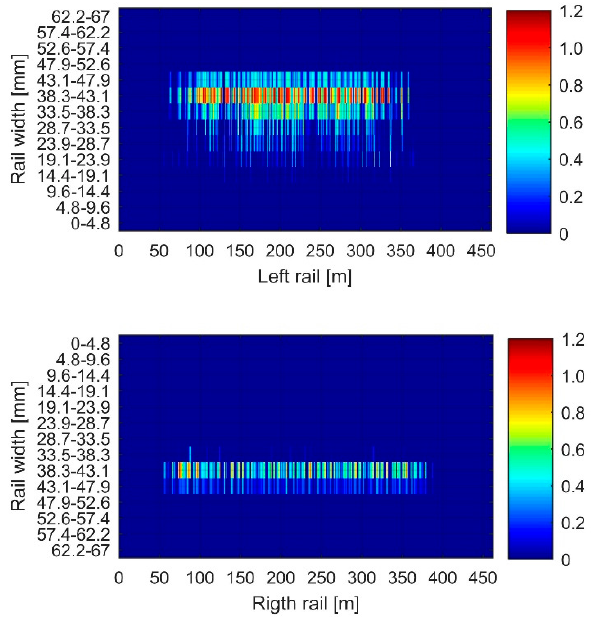
Figure 3. DI distribution for each division of the rail cross-section. (ycr: lateral position of the con- tact patch center; wp: width of the contact patch).